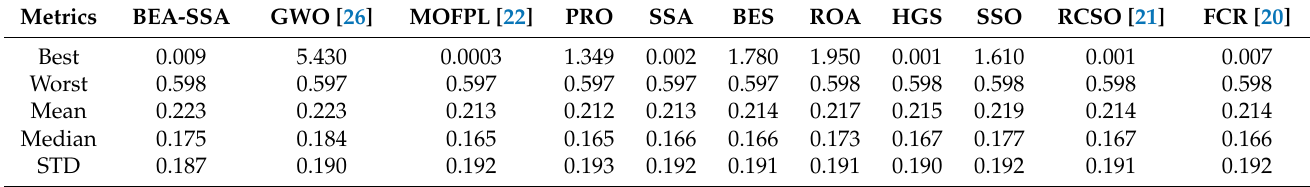
Table 5. Statistical Analysis on BEA-SSA compared with other models for 200